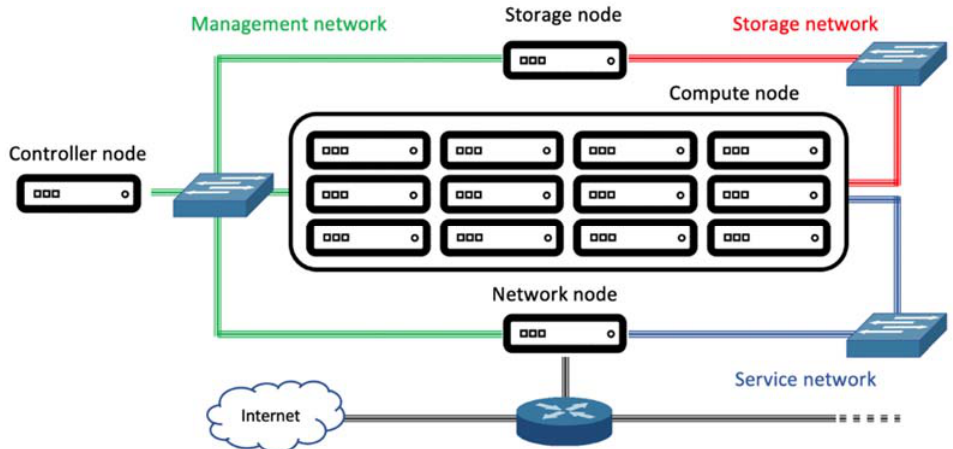
Figure 1. OpenStack ‐ based experimental setup and connectivity. Figure 1. OpenStack-based experimental setup and